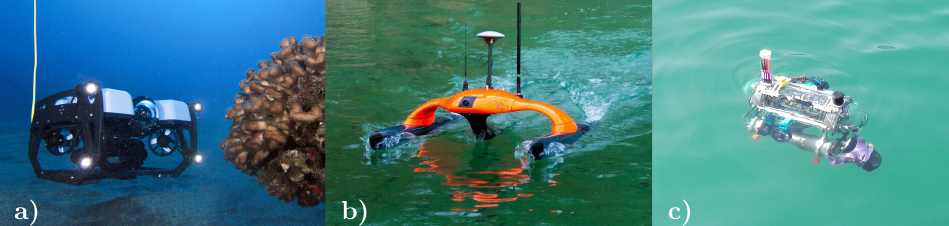
Figure 1. Examples of: ( a ) Remoted Operated Vehicle, BlueROV2 from BlueRobotics reproduced from https://bluerobotics.com/store/rov/bluerov2 (last accessed: 11 October 2021), courtesy of Blue Robotics Inc-Copyright 2021; ( b ) Autonomous Surface Vehicle, Sonobot System from EvoLogics reproduced from https://evologics.de/sonobot-system (last accessed: 11 October 2021) courtesy of EvoLogics GmbH-Copyright 2018; ( c ) Autonomous Underwater Vehicle, FeelHippo AUV from the Department of Industrial Engineering, University of